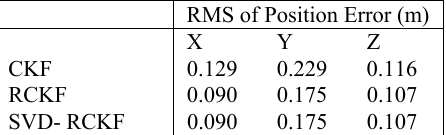
Figure 1. The vehicle trajectory of case 1